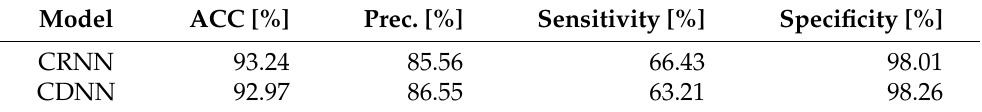
Table 7. Results of the models on the validation set, depending on the type of architecture. The data come from the best epochs. They were obtained by the fivefold cross-validation method.